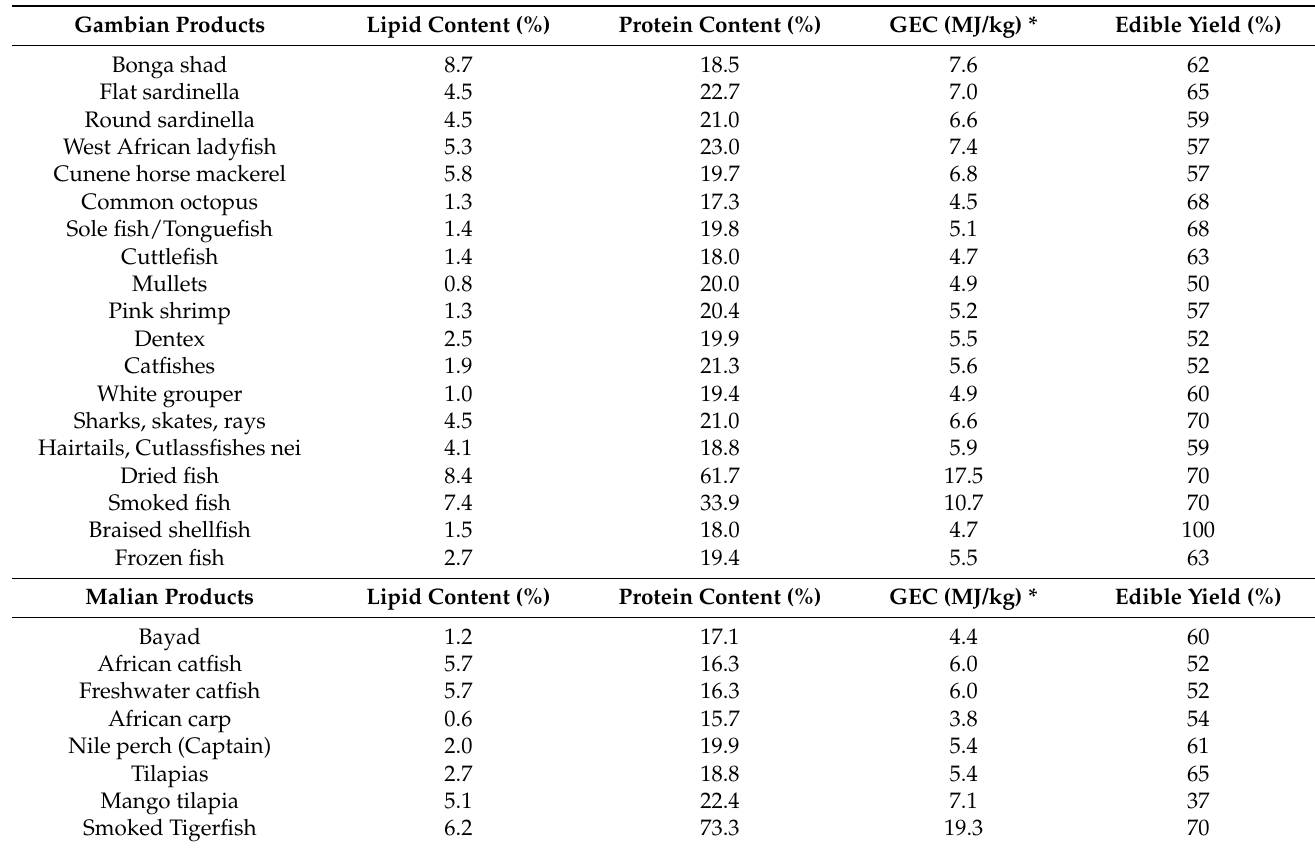
wood for fish smoking (Figure 6b). Gambian-processed shellfish features rather high PPI, due to relatively lower impacts associated with collection and braising. The EROI of fish products imported to Mali are low due to the energy expenditures of the refrigerated transport and energy needed to produce a concentrated feed. In contrast, for instance, Peruvian-cultured tilapia features EROI values of 4.3 (0.03 for frozen tilapia imported from China to Mali) [22]. Table 4. Fat, protein, gross energy content (GEC) and edible yield of the main species and fish products of the Gambia and